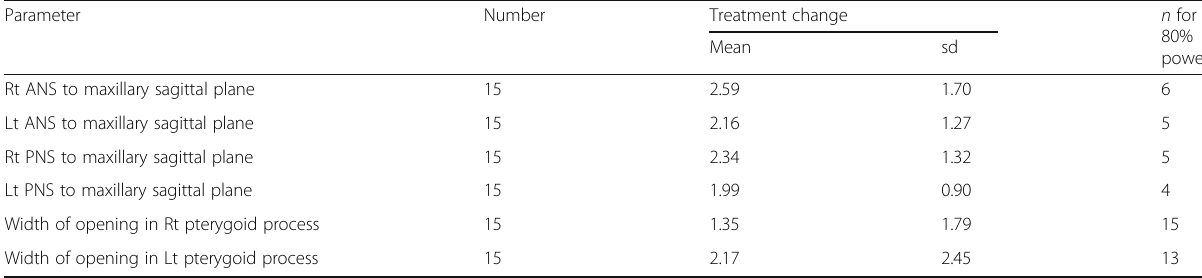
Table 1 Sample size analysis for 80% power, with 0.05 alpha value Parameter Number Treatment